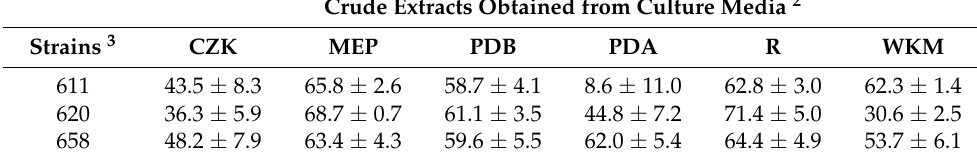
Table 2. Percentage mean of inhibition of proliferation of human colon carcinoma cell line (HCT-116) from the extracts obtained of fungi strains growth on different culture media 1